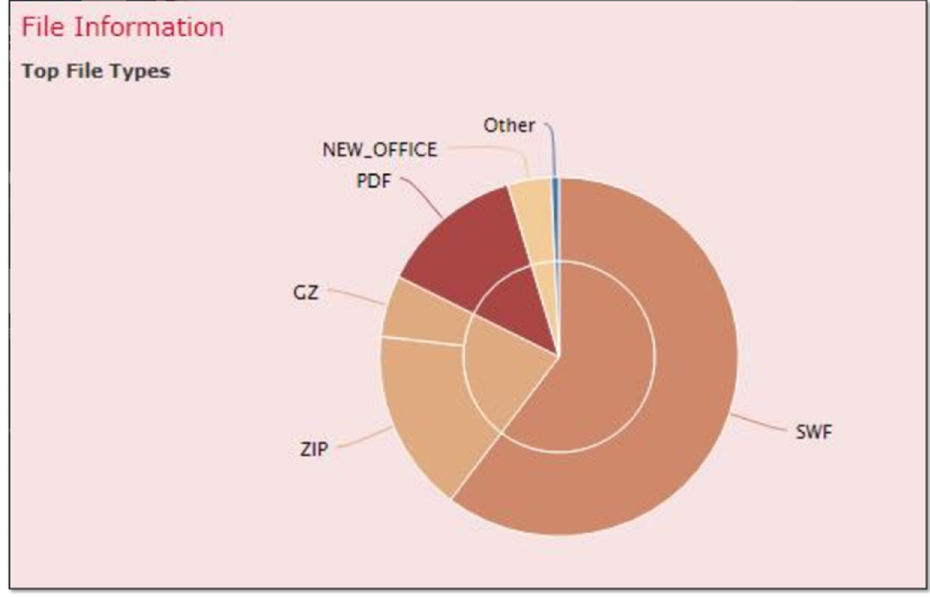
Figure 7. Top File Types extracted from Firepower.